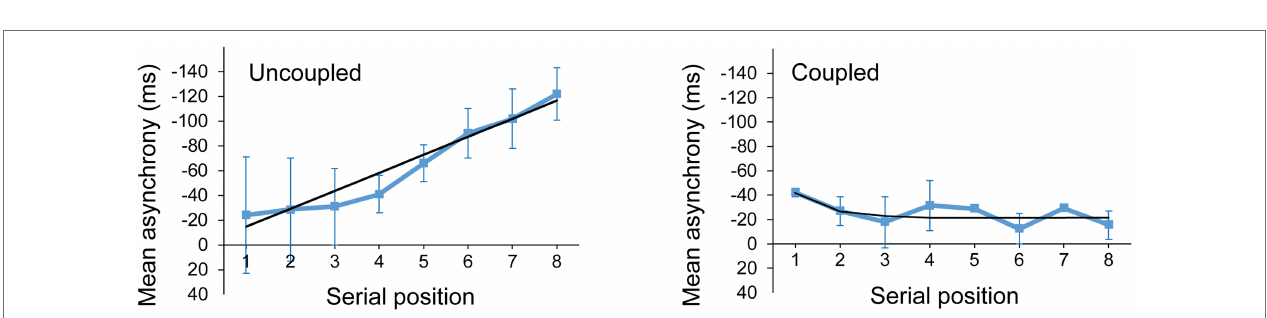
FIGURE 6 | Mean asynchronies and model fits for a trial better fit by the linear (uncoupled) model (left) and a trial better fit by the delay-coupled model (right). The black line represents the model predicted